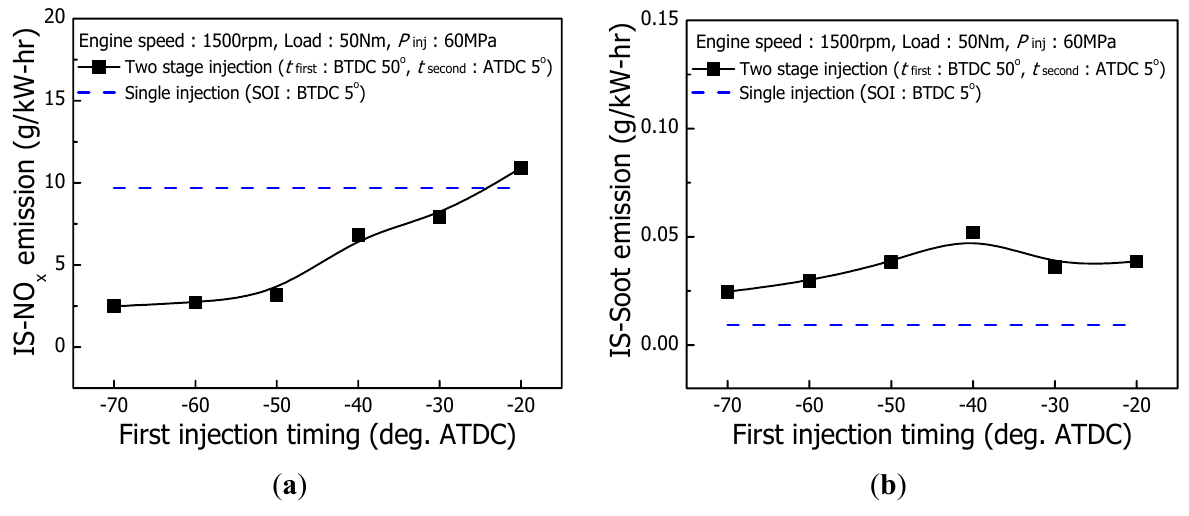
Figure 6. IS-NO and IS-Soot emission characteristics according to first injection timing of x ; ( b ) two stage injection: ( a ) IS-NO x